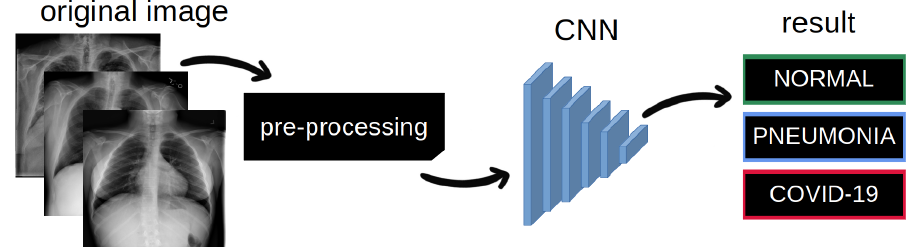
Fig 2. The overview of the proposed